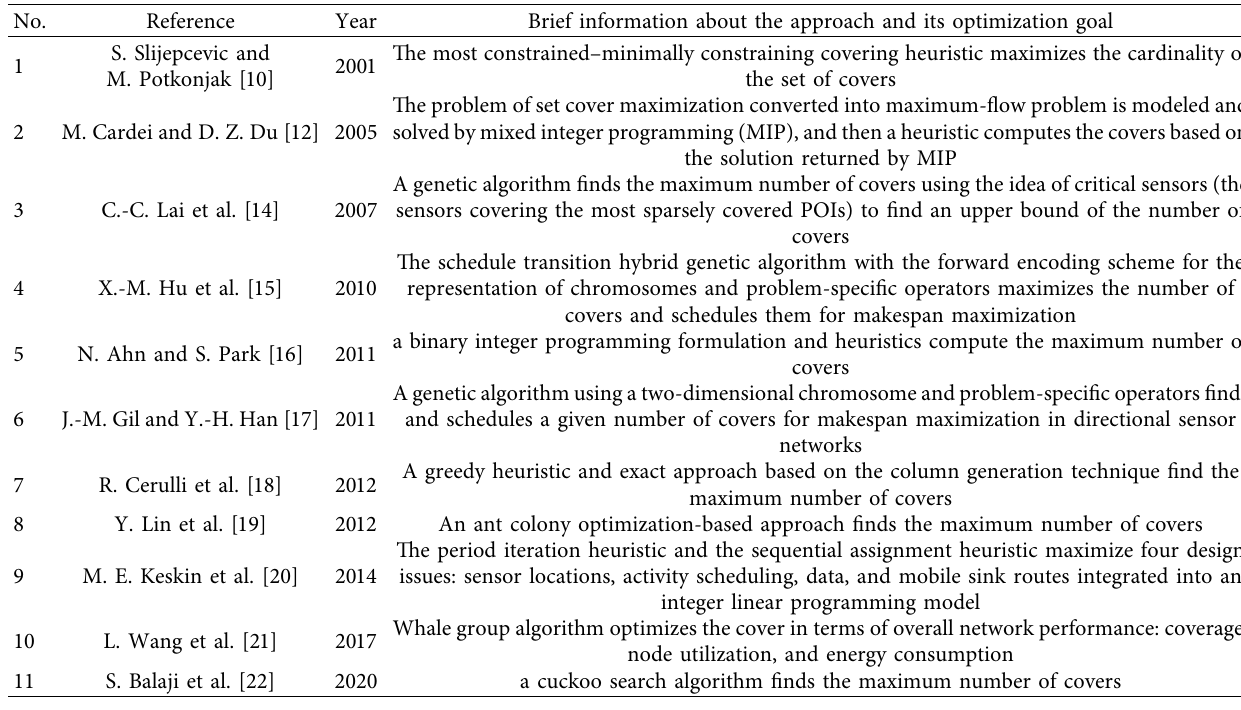
Table 1: Selected papers on MLCP optimization with Disjoint Set Cover based approaches.